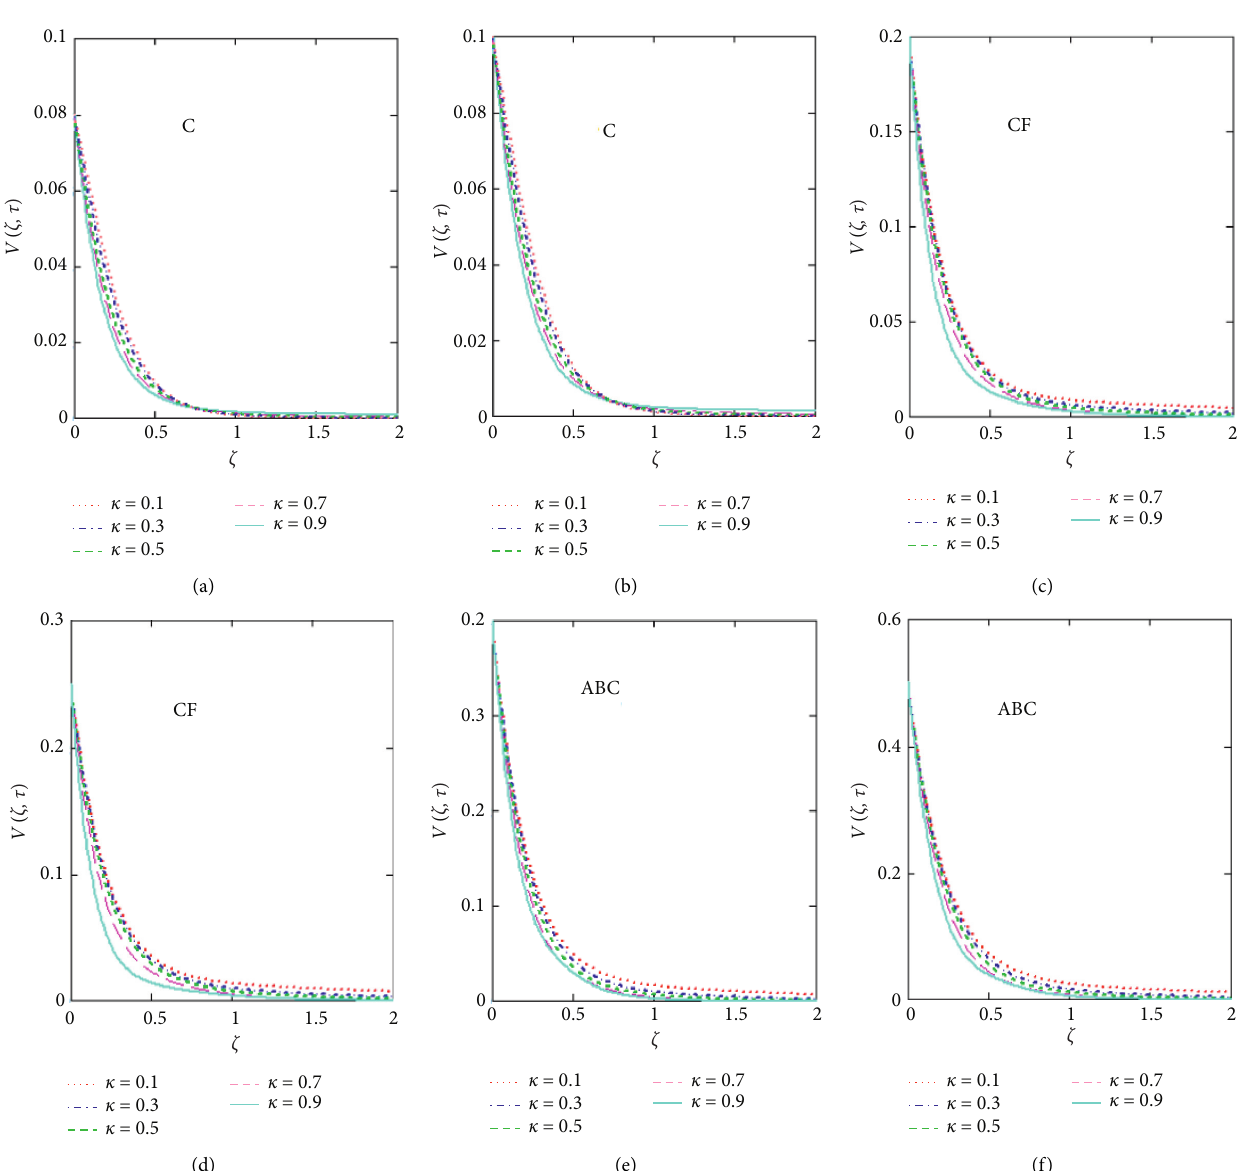
Figure 3: Plot via C, CF, and AB approaches for velocity with different values of κ